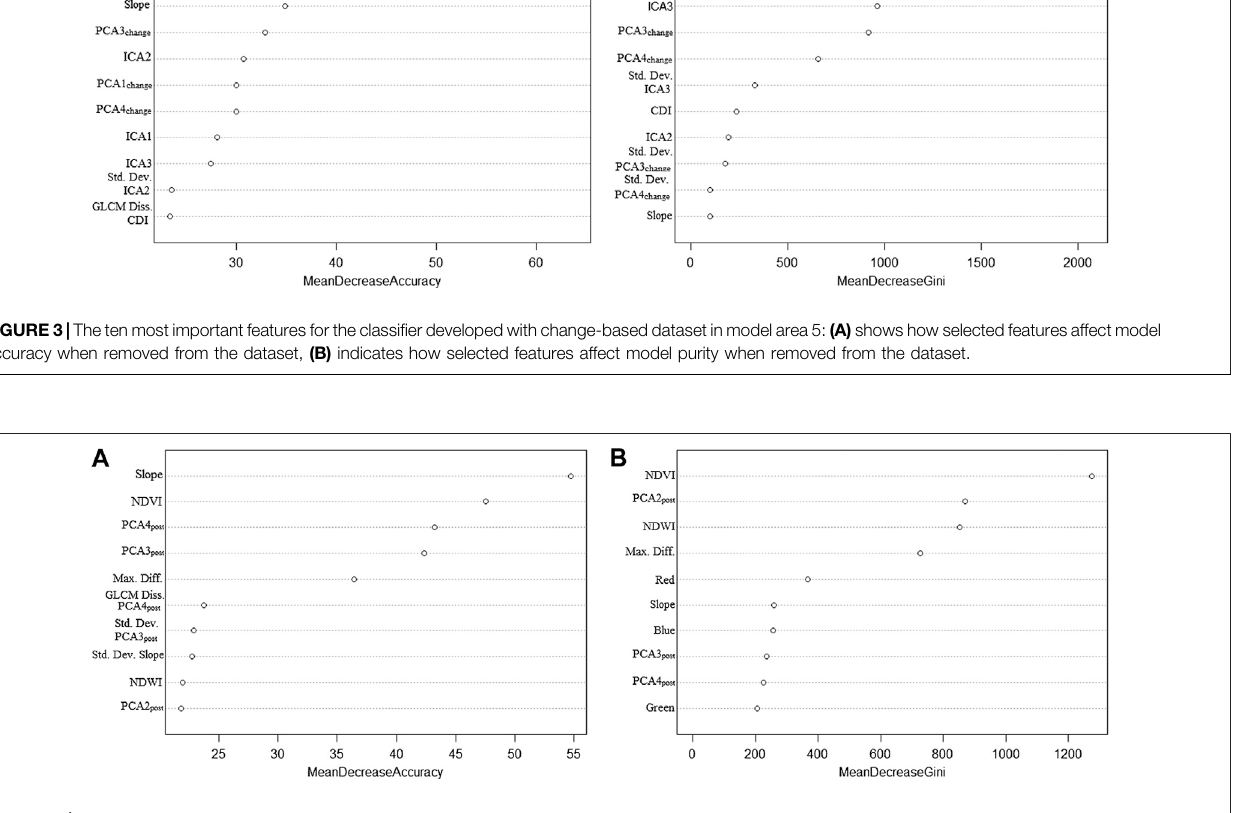
( Figure 4 ). When the importance of properties for different datasets is evaluated, it is seen that spectral properties and spatial properties are more effective in mapping landslides according to textural properties.